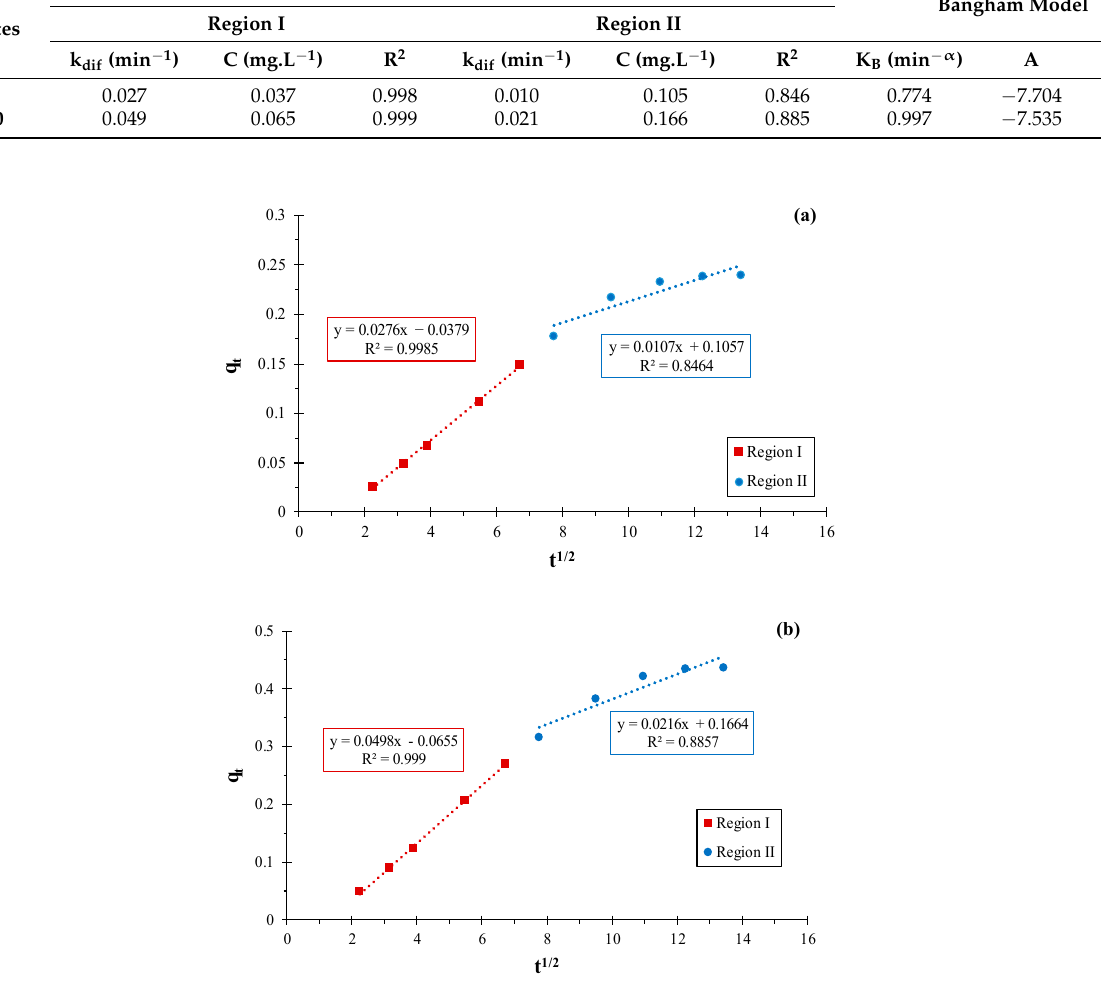
Figure 6. Bangham kinetic model representation for RhB adsorption on ( a ) KS44 ‐ 0 and ( b ) KS44 ‐ 20.